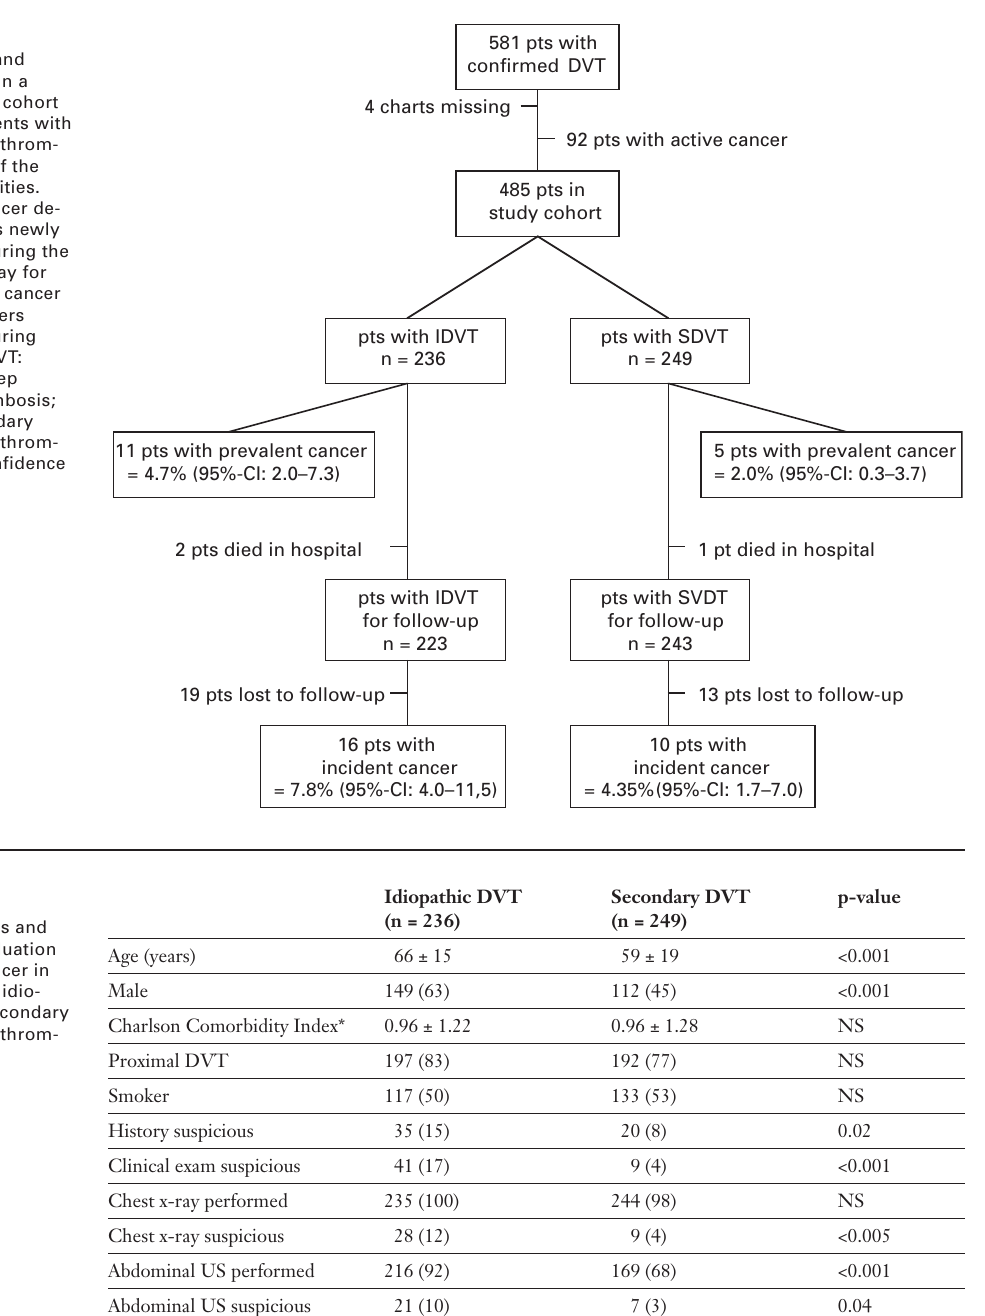
Demographics and extent of evaluation for occult cancer in patients with idio- pathic and secondary deep venous throm-